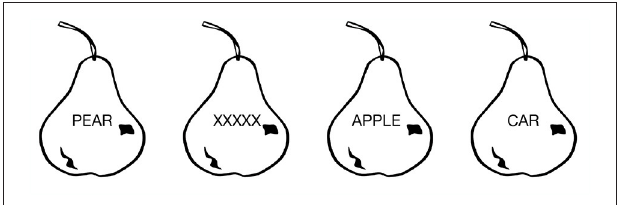
FIGURE 2 | Conditions of a Picture–Word Interference experiment. From left to right: the congruent , neutral , semantic , and unrelated conditions (see text).